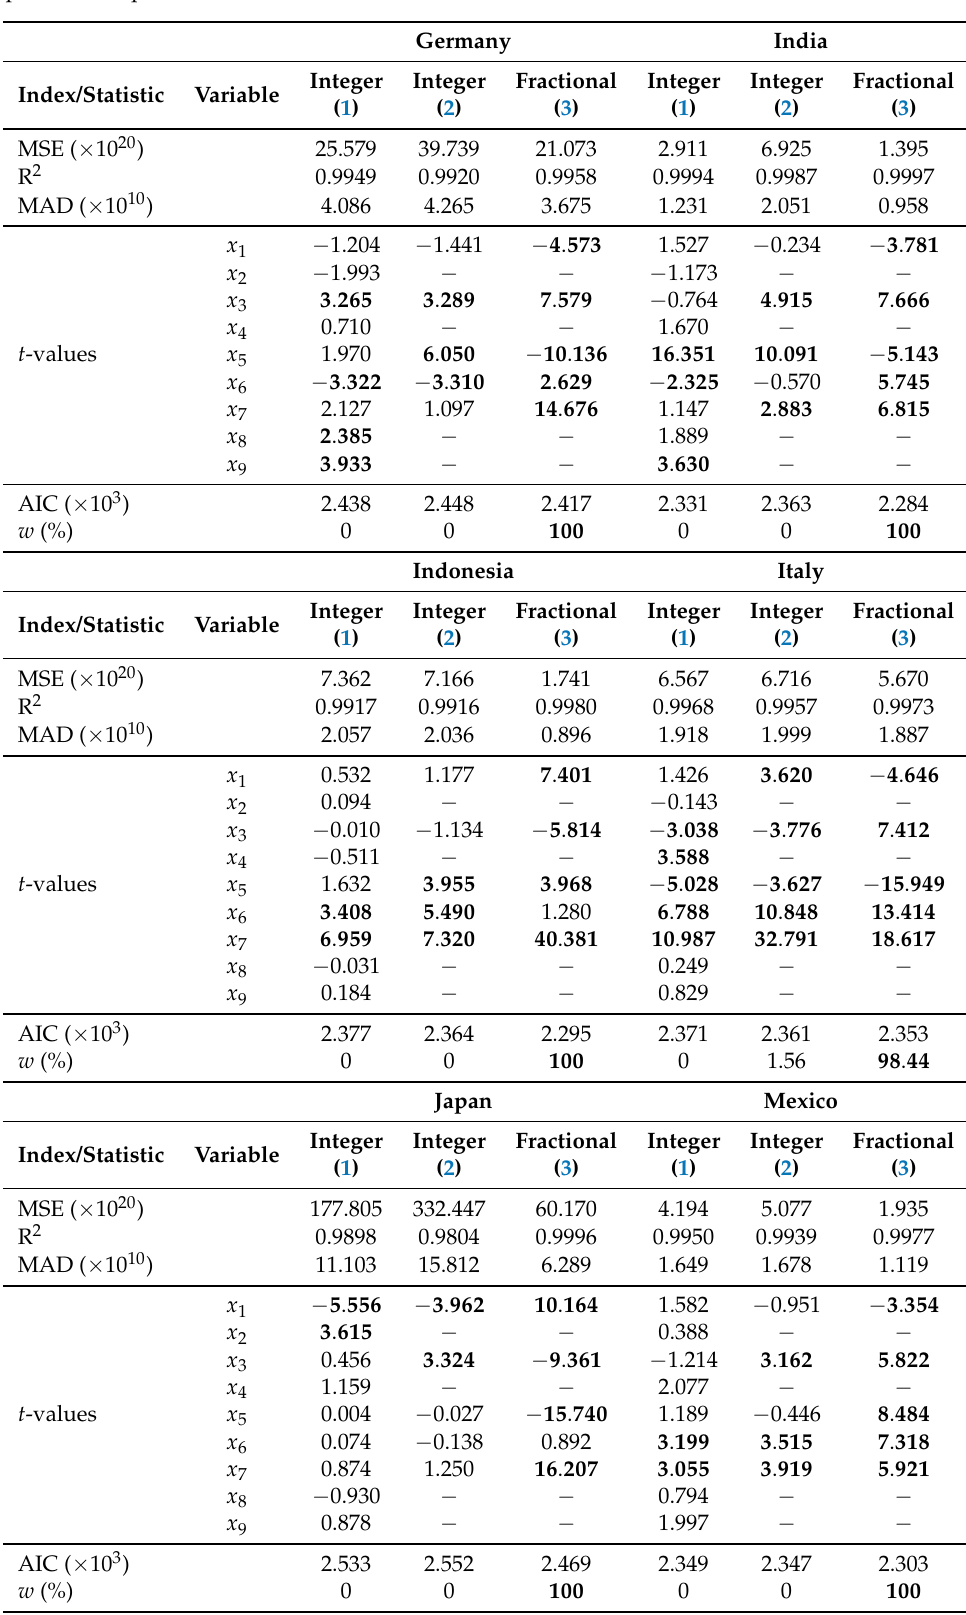
Table 2. Performance indices of the different models obtained for the G20 members in Figure 3; for an explanation of performance assessment see Section